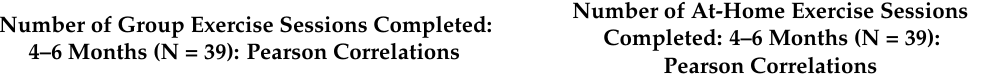
Table 1. Correlational Associations Between Sleep (assessed at Six Months) and Number of Group and At-Home Aerobic Sessions Completed.